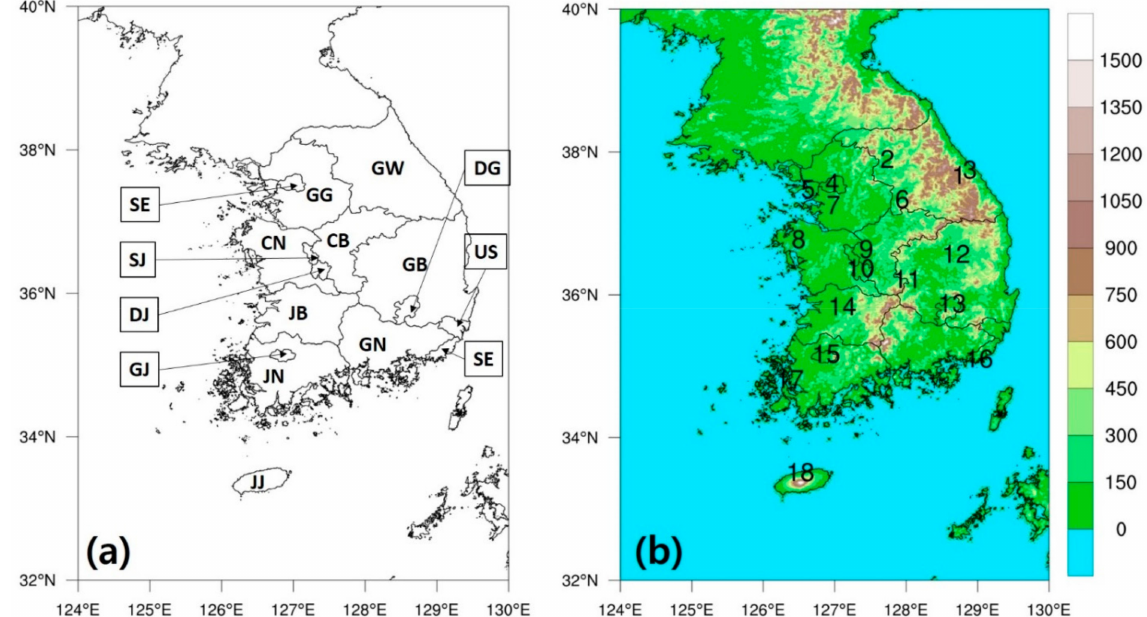
Figure 1. Map of the research area and 17 administrative divisions in Korea ( a ) and the topography and the locations of the ground observations ( b ). The number in ( b ) indicates the station index in Table